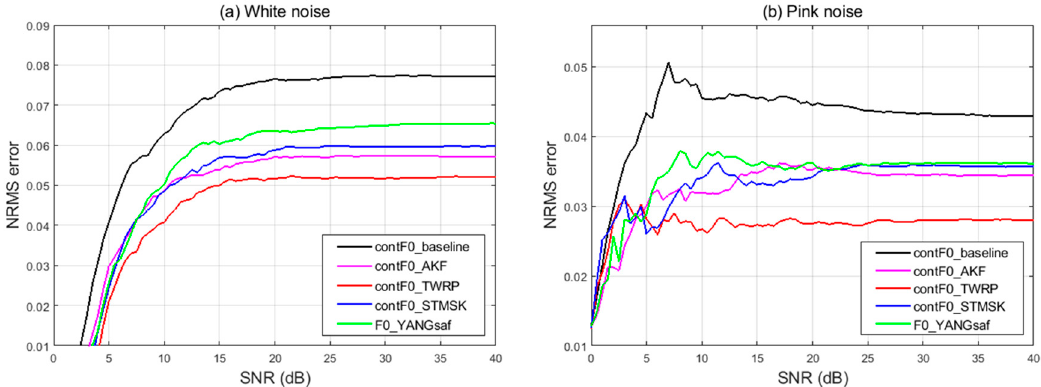
Figure 7. Influence of the SNR on the average normalized RMSE with proposed refined contF0_AKF (adaptive Kalman filter), contF0_TWRP (time-warping), and contF0_STMSK (StoneMask) methods.